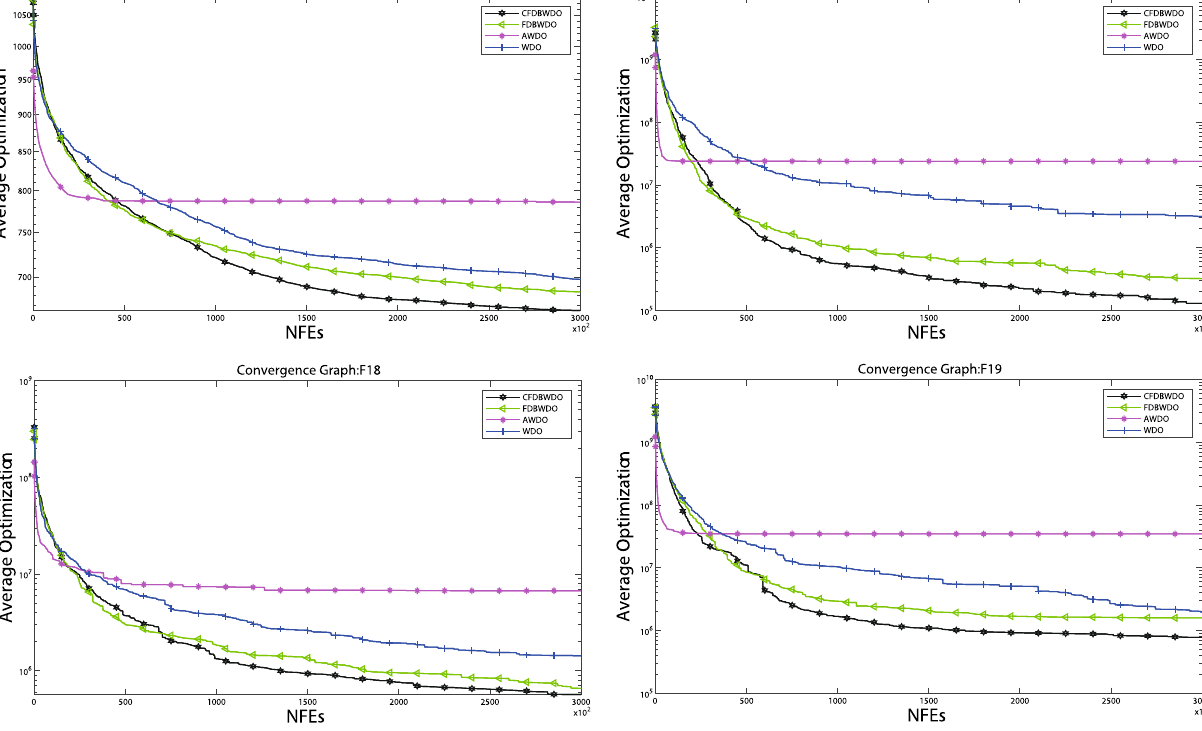
Fig. 6 Convergence graphs of four WDO variants on F5, F15, F18 and F19 with 30